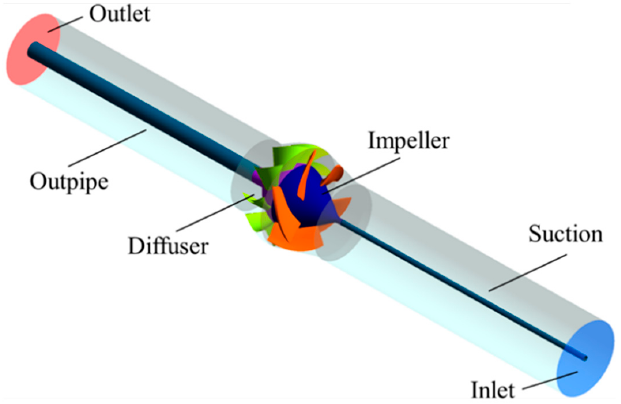
Figure 4. Domain of hydraulic components [28].